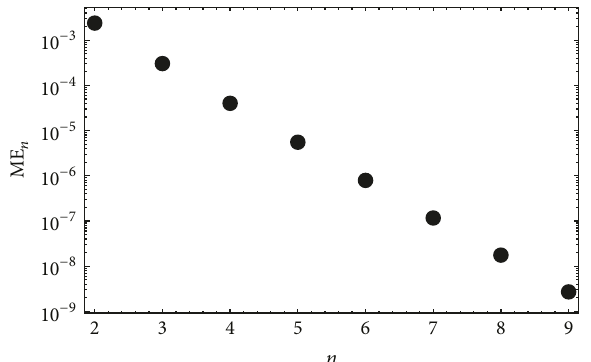
Figure 3: Logarithmic plots of the maximal errors ME 𝑛 versus 𝑛 for 𝑛 = 2 through 9 obtained by the Duan-Rach modified ADM.